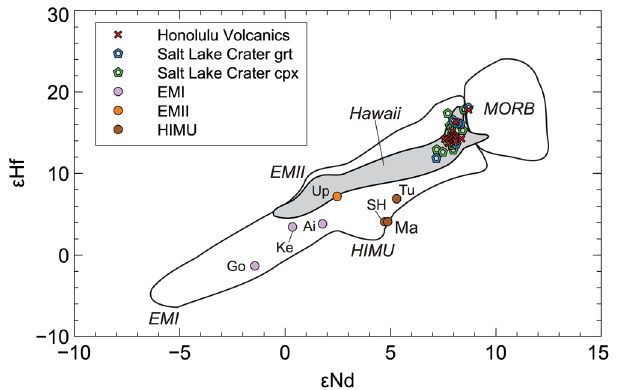
Fig. 1 Plot of ε Nd versus ε Hf showing the fi elds for MORB, Hawaii (shaded), OIB, and the positions of endmember mantle component OIB; EMI, EMII and HIMU. Also shown are averages for selected endmember component islands where Hf isotopic data were available (Go = Gough, Ke = Kergulen, Ai = Aitutaki, Up = Upolu, SH = St.Helena, Ma = Marquesas, Tu = Tutila). The Salt Lake Crater garnet pyroxenite minerals and Honolulu Volcanic rocks (HV) show depleted-mantle compositions and plot adjacent to the MORB fi eld. Fields on the diagram (e.g. Hawaii), the review of HV isotopic compositions, and garnet pyroxenite isotopic ratios are from Bizimis et al. 21 . Averages for endmember mantle component islands were calculated using data downloaded from the GEOROC